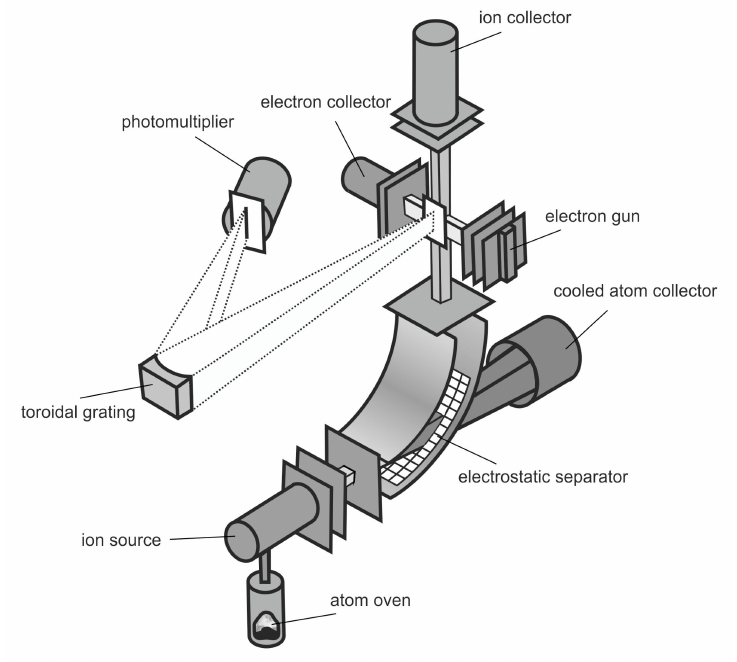
Figure 1. Schematic representation of the experimental